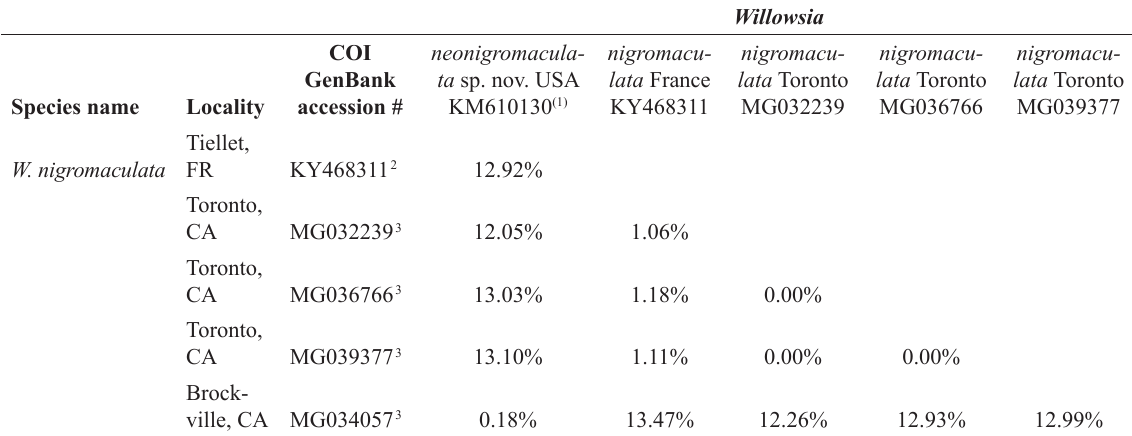
Table 3. COI p-distances between Willowsia nigromaculata (Lubbock, 1873) and W. neonigromaculata sp. nov. References: Katz et al . 2015a 1 ; Ding et al . 2018 2 ; deWaard et al . 2019 3 . Abbreviations: CA = Canada; FR =